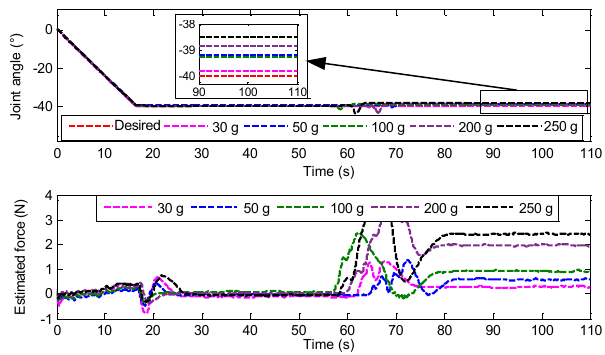
Figure 26. Positive direction loading experiment results at − 40 ◦ .